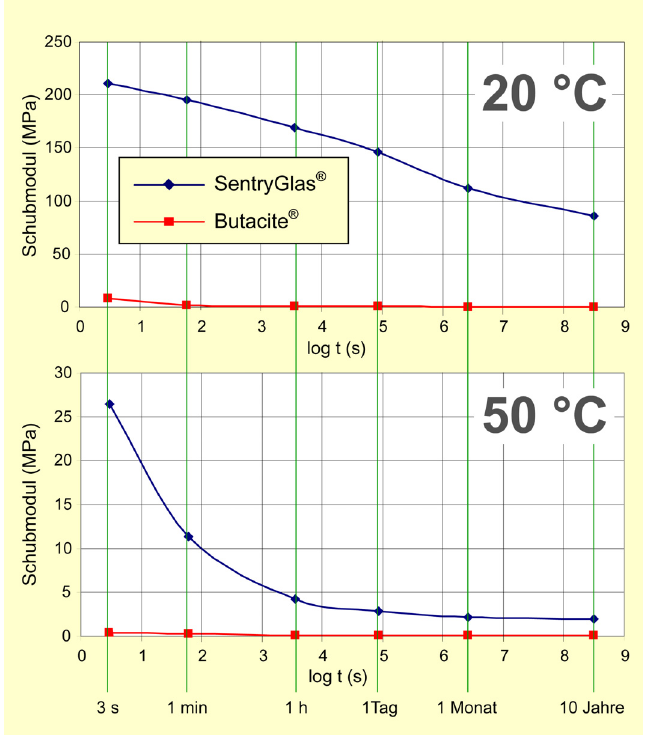
Schubmodul = Shear modulus; Tag = Day; Monat = Month; Jahre = Years Figure 3: Stiffness (shear modulus) of PVB and SentryGlas® interlayers at room and elevated